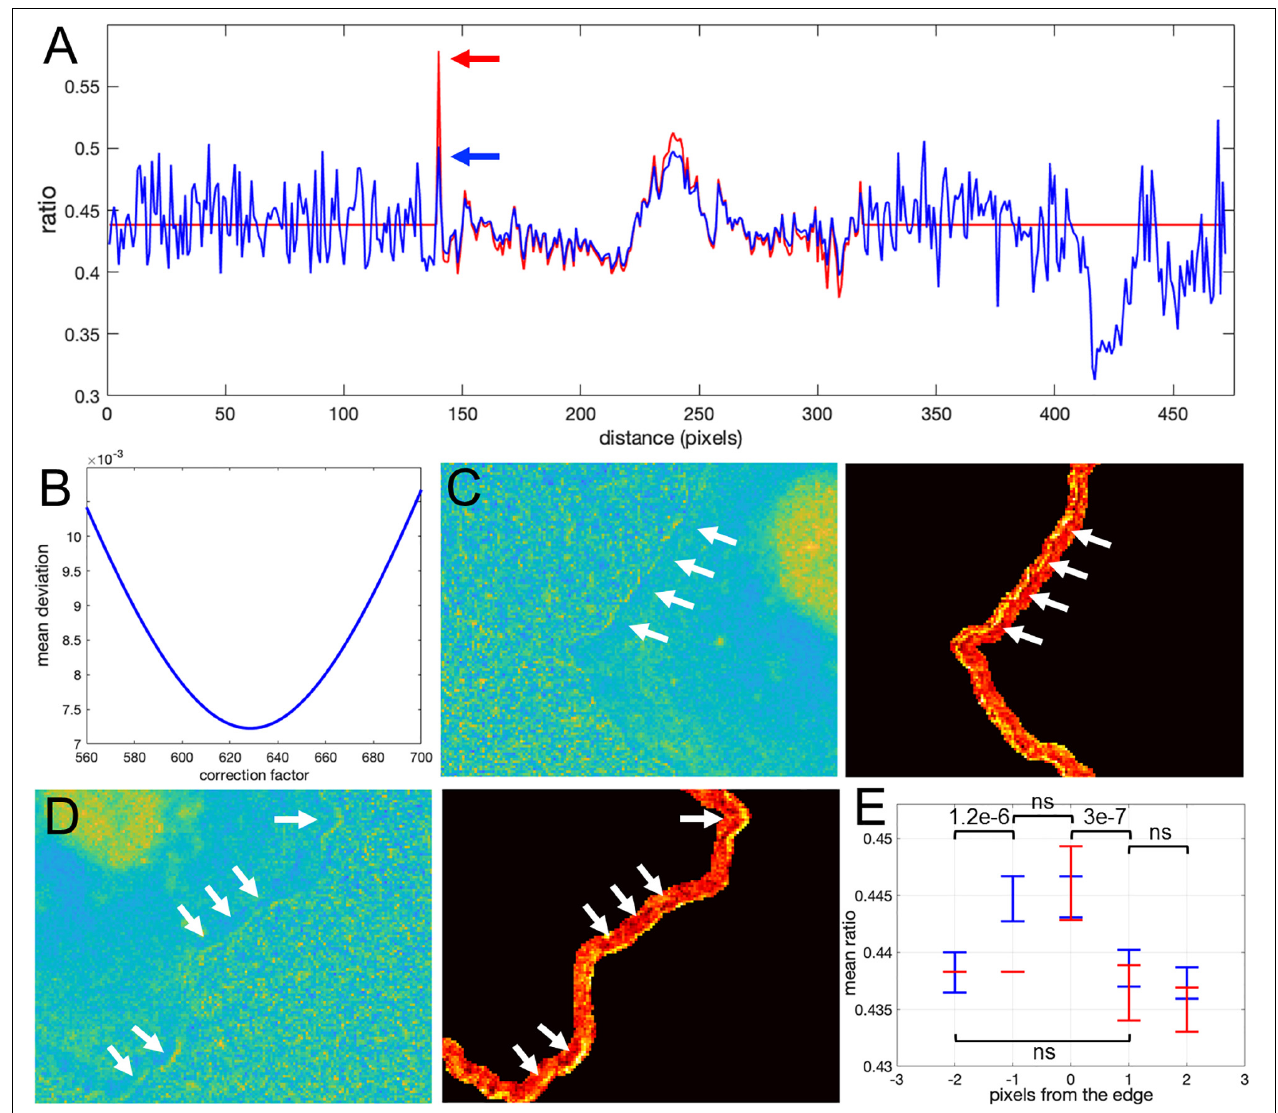
FIGURE 8 | Application of the correction factor method to Asef biosensor data. (A) The ratio values along a line in the ratio image resulting from the mean background subtraction method (red) and from the NCF method (blue). The red arrow indicates a pixel where the MBS method gives an artefactually high ratio value (noise-related artifact). The NCF method gives a value (blue arrow) that is within the distribution of ratio values seen throughout the cell (free of the noise related artifact). (B) The deviation function (Equation 5) for a range of NCF values. The correction factor giving the minimum deviation is used. (C,D) Two different zoomed-in regions of the ratio image calculated with the NCF method. Each zoomed-in region is presented in two colormaps. The regions are from the left and right sides of the cell shown in Figure 7C . For better contrast, the panels on the right also exclude all regions from the view except for the near edge region. White arrows point to a narrow band of bright pixels at the very edge of the cell. (E) Statistical measurement of the activity distribution (mean plus/minus two standard errors) for pixels along the contours at different distances from the cell edge. Blue and red color represents the result of the NCF and MBS methods, respectively. On average, a two-pixel band is elevated over the noise seen beside the band, either inside or outside the cell. The statistical significance of the differences in the mean values for the NCF results is indicated with p -values of the two-sample t -test (“ns” stands for p ≥